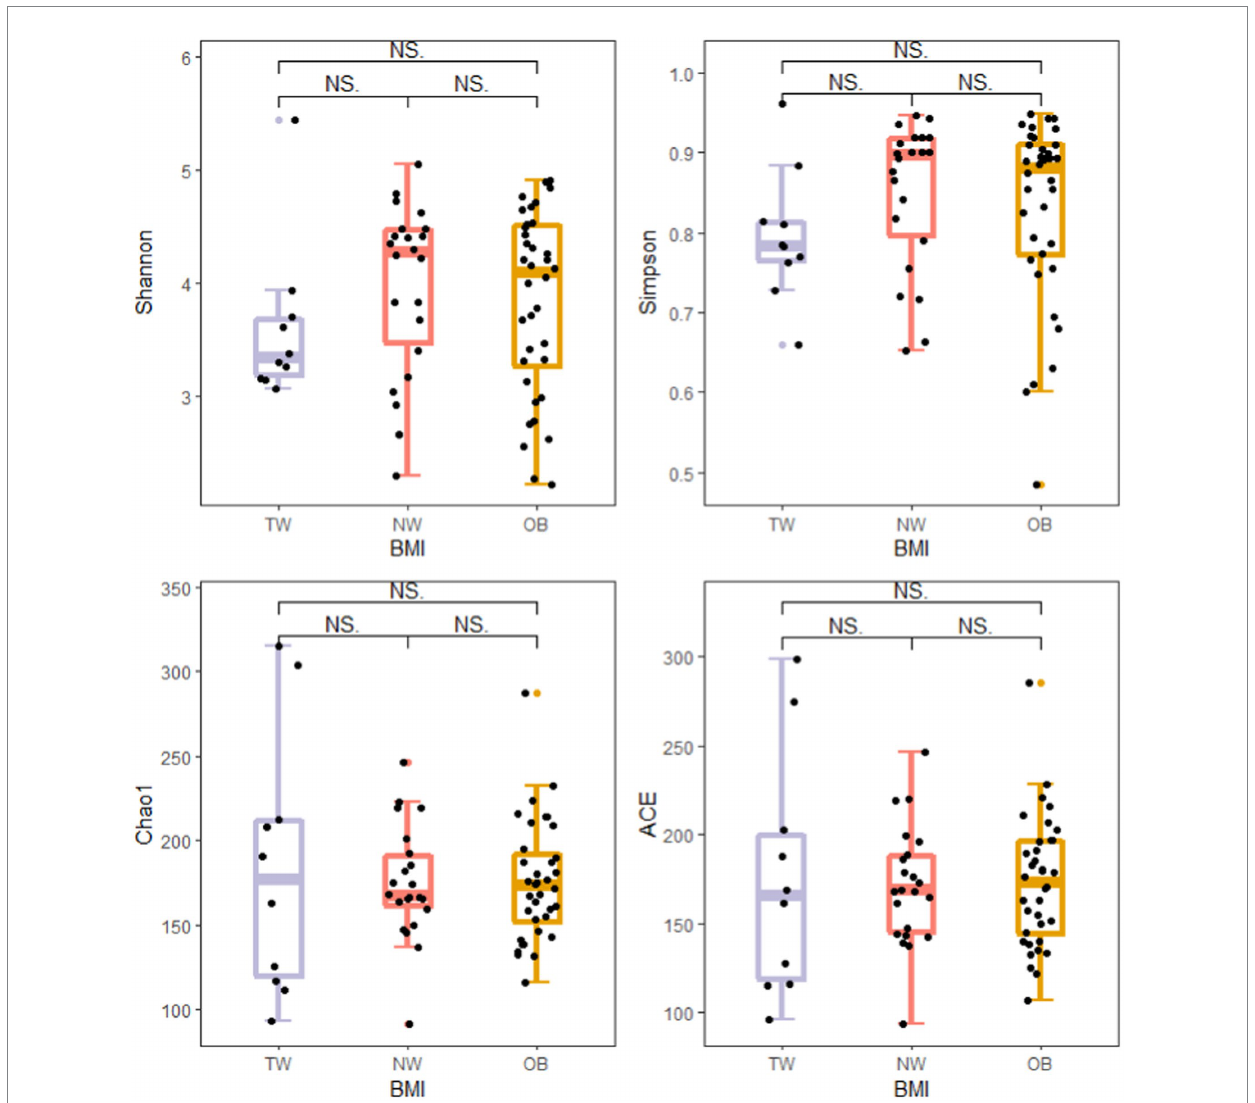
FIGURE 2 Comparison of alpha diversity indexes among groups. Alpha diversity of the gut microbiota was analyzed using the ggplot2 package and ggsignif package in R v4.1.3. t -test was used to test for significant differences in alpha diversity. NS p > 0.05, * p ≤ 0.05, and ** p ≤